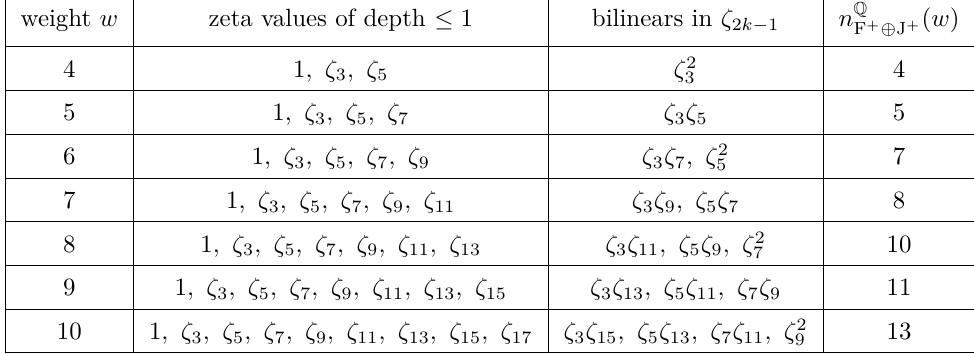
Table 6 . Zeta values occurring in the Laurent polynomials of even modular invariants of depth